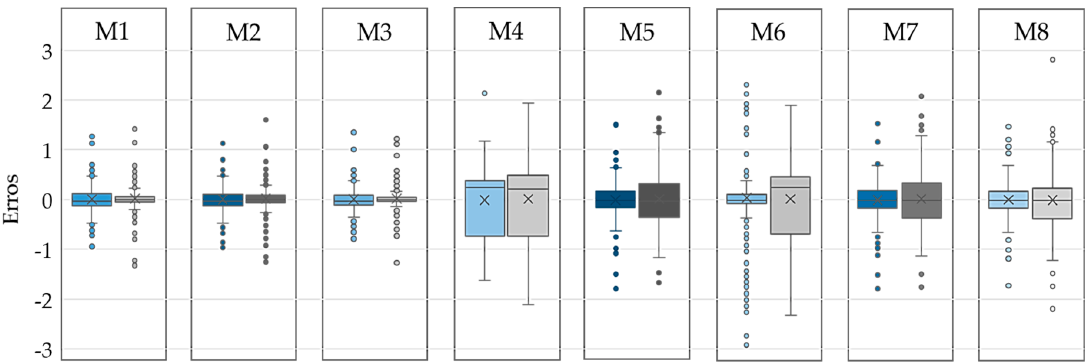
Figure 7. Error bars shown in blue and gray for models without and with feature selection, respectively with holdout validation.